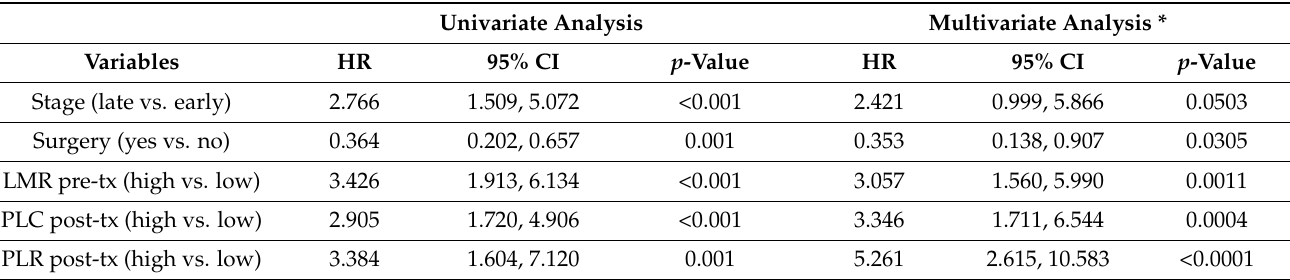
Table 5. Variable associated with overall survival (OS) when both pre- and post-treatment markers were included in the